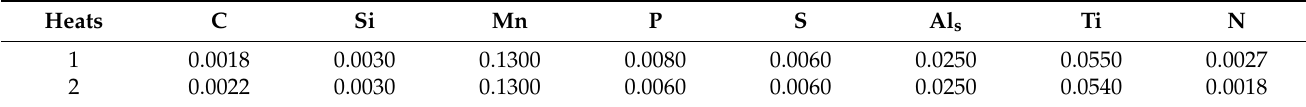
Table 2. Chemical composition of Ti-bearing IF steel (wt%).